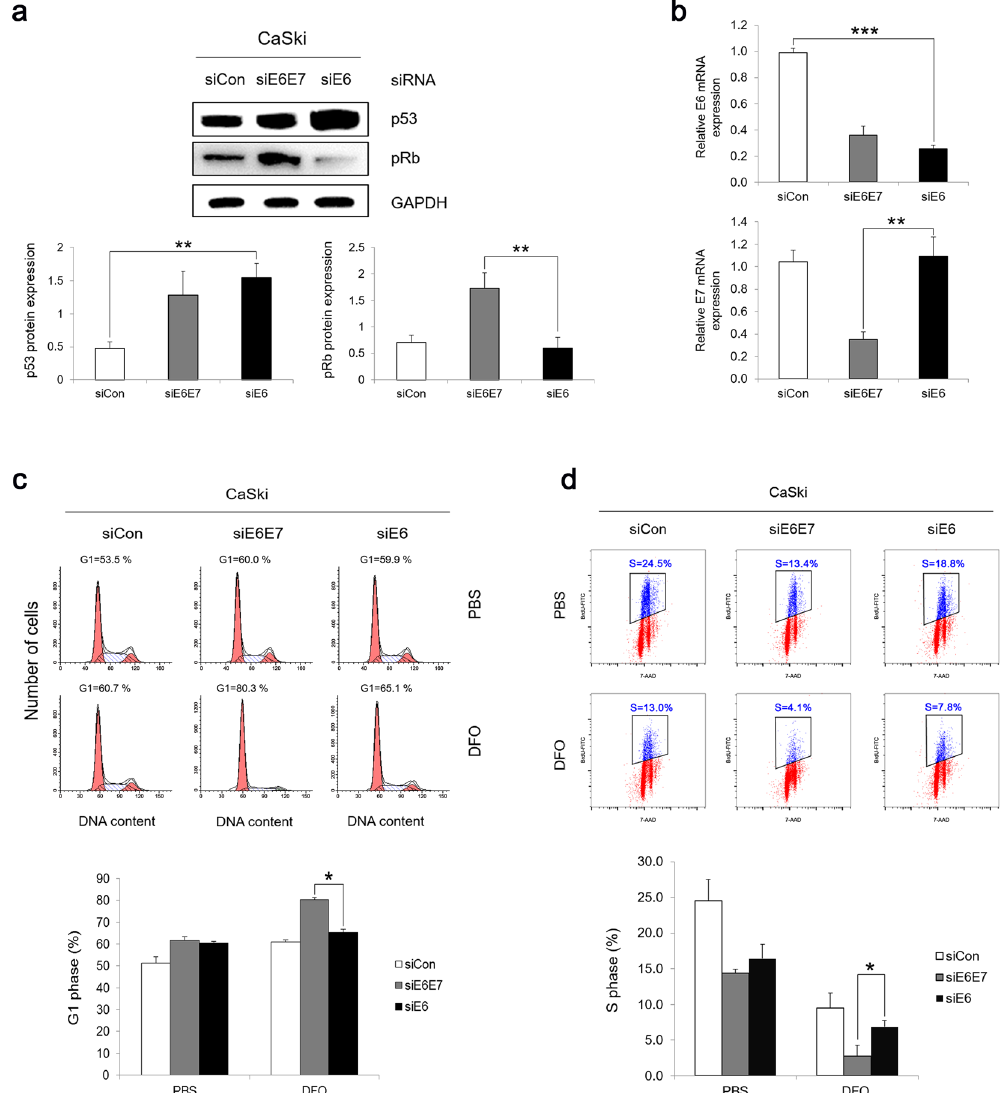
Figure 2. Hypoxia leads to G1 arrest in HPV-16 E7 knockdown cervical cancer cells. HPV-16 positive CaSki cells were transfected with siRNAs targeting E7 or E6 (siRNA198 or siRNA209). ( a ) Forty-eight hours later, the steady-state levels of p53 and pRb were examined by Immunoblotting (full-length blots are presented in Supplementary Figure 1). ( b ) Thirty-six hours post-transfection, the mRNA levels of HPV-16 E6 and HPV-16 E7 were determined by RT-qPCR. ( c ) Twenty-four hours post-transfection, cells were treated with 200 μ M DFO for 8 hours. Cells were stained with PI and analyzed by flow cytometry. A representative experiment of 3 is shown (Upper panel) and summarized (Lower panel). ( d ) Twenty-four hours after transfection, cells were treated with 200 μ M DFO for 6 hours and then labeled with BrdU for 2 additional hours. Cells were stained with anti-BrdU antibody, counterstained with 7-AAD, analyzed by flow cytometry. Data from a representative of 3 experiments are shown (Upper panel) and the percentage of BrdU-positive cells was gated. Mean percentage of BrdU positive CaSki cells are summarized (Lower panel). Error bars reflected the standard error of the mean. * P < 0.05; ** P < 0.01; *** P <